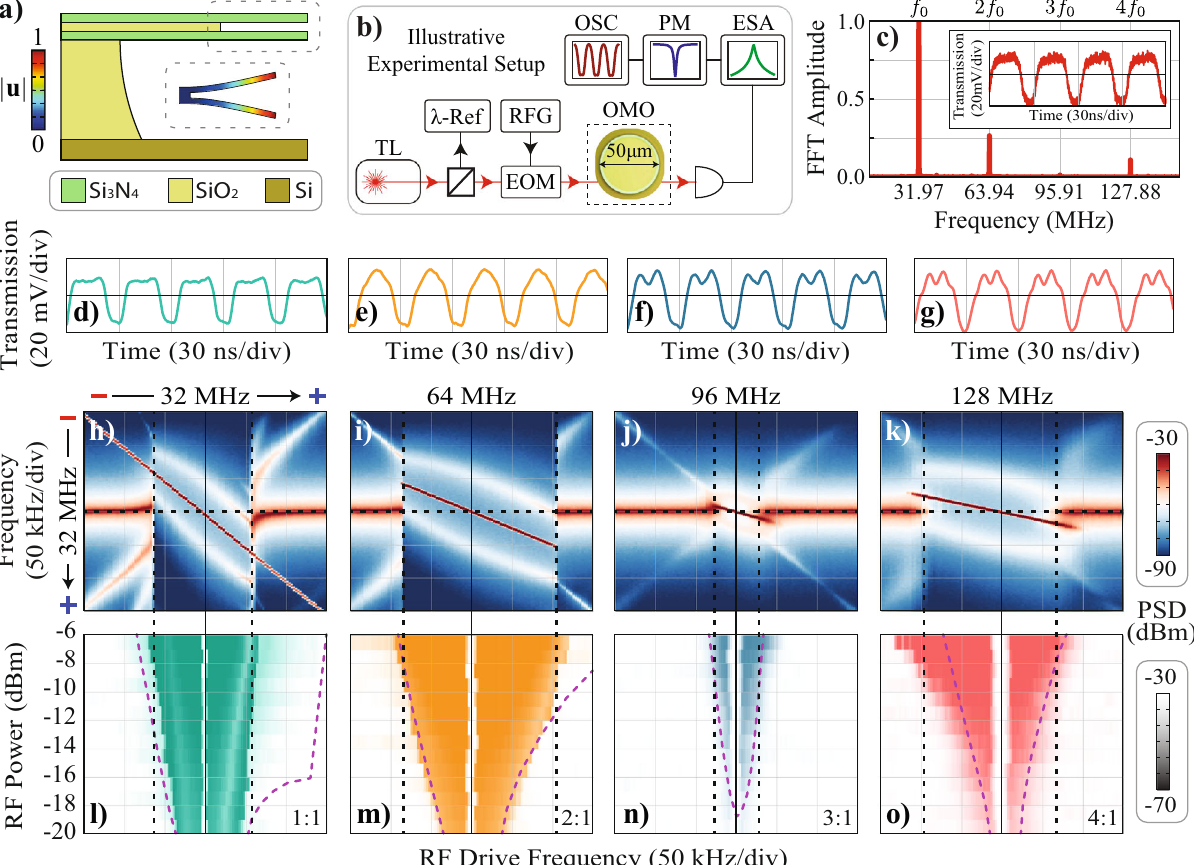
Fig. 2 Experimental demonstration of multi-octave synchronization. a Illustration of the silicon nitride dual-disk optomechanical cavity used in the experiment. The inset shows the simulated fl apping mechanical mode displacement pro fi le ∣ u ∣ ; b Schematic of the experimental setup used; TL is the tunable laser source; λ -Ref: acetylene gas cell and a Mach-Zehnder interferometer as a reference in frequency; EOM: electro-optic modulator; RFG: radio- frequency generator; ESA: electrical spectrum analyzer; PM: power meter; OSC: oscilloscope; c Magnitude of the fast-Fourier transform of the OMO output signal (inset); d – g Time-trace of the OMO output entrained at p = 1 ( d ) until p = 4 (at g ). A RF injection power of − 10 dBm ( ε ≈ 4%) was used; h – k RF spectrograms measured as the RF drive frequency sweeps from lower to higher frequencies around each OMO harmonic, p = 1 ( h ) until p = 4 (at k ), for an injection RF power of − 10 dBm. The vertical RF frequency axis is always centered at the mechanical oscillation frequency Ω 0 /2 π = 32 MHz and increases from top to bottom, as the symbols minus and plus from h ) suggests. The same is true for the horizontal axis, in which the RF drive frequency increases from the left to the right; l – o Measured Arnold tongues corresponding to each harmonic, obtained by stacking horizontal linecuts along the dashed black line shown in h – k . The purple curves are the simulated ATs and the color scale of each plot matches the grayscale range shown in the